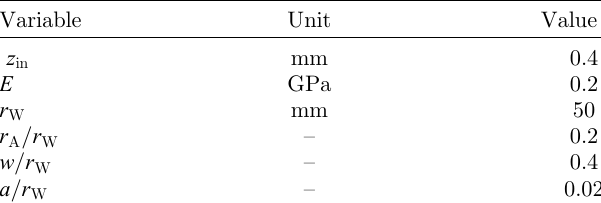
Table 2. Values used for the fi xed variables.